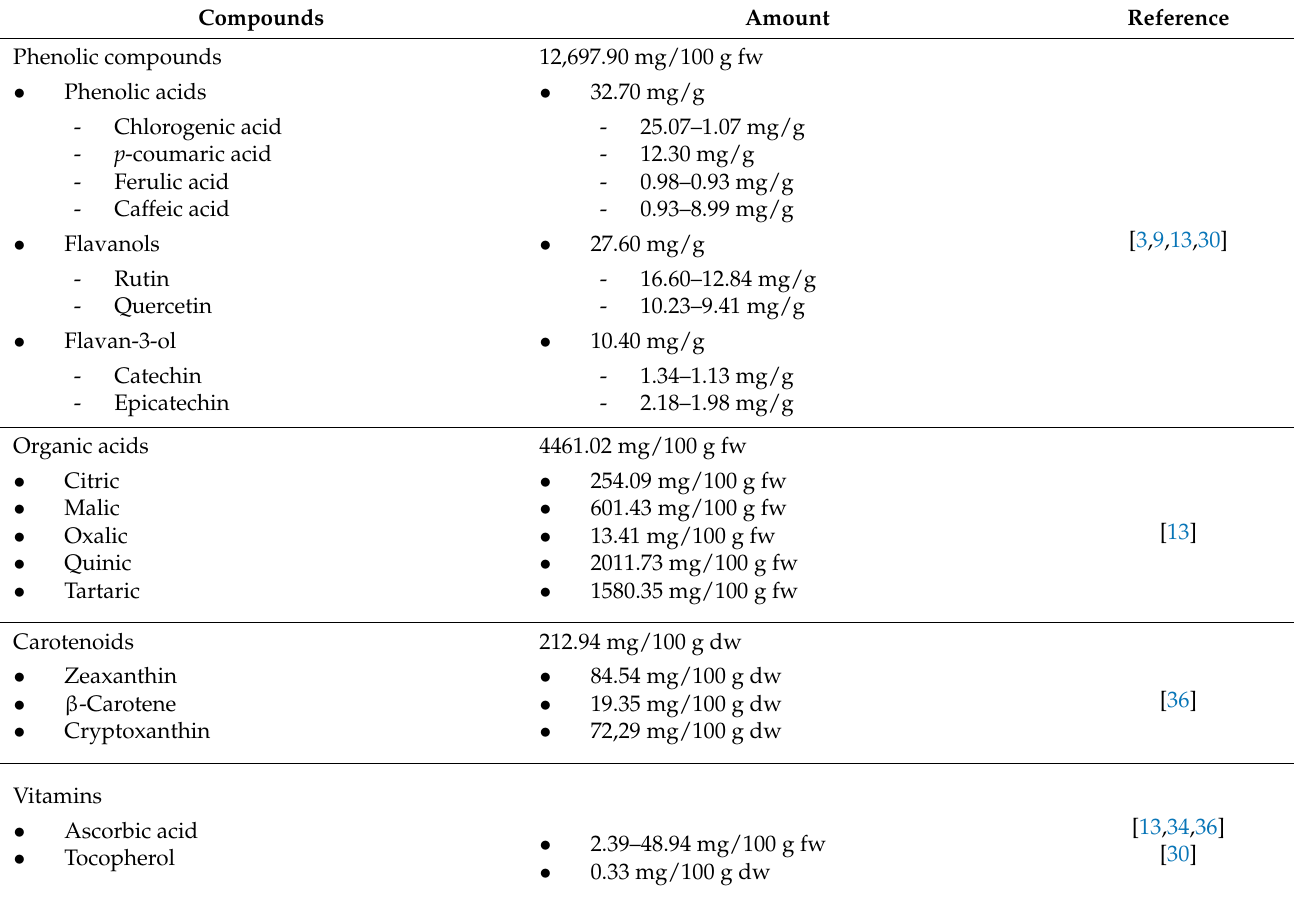
Table 2. Phytochemical and nutritional composition of L. barbarum berries, according to different